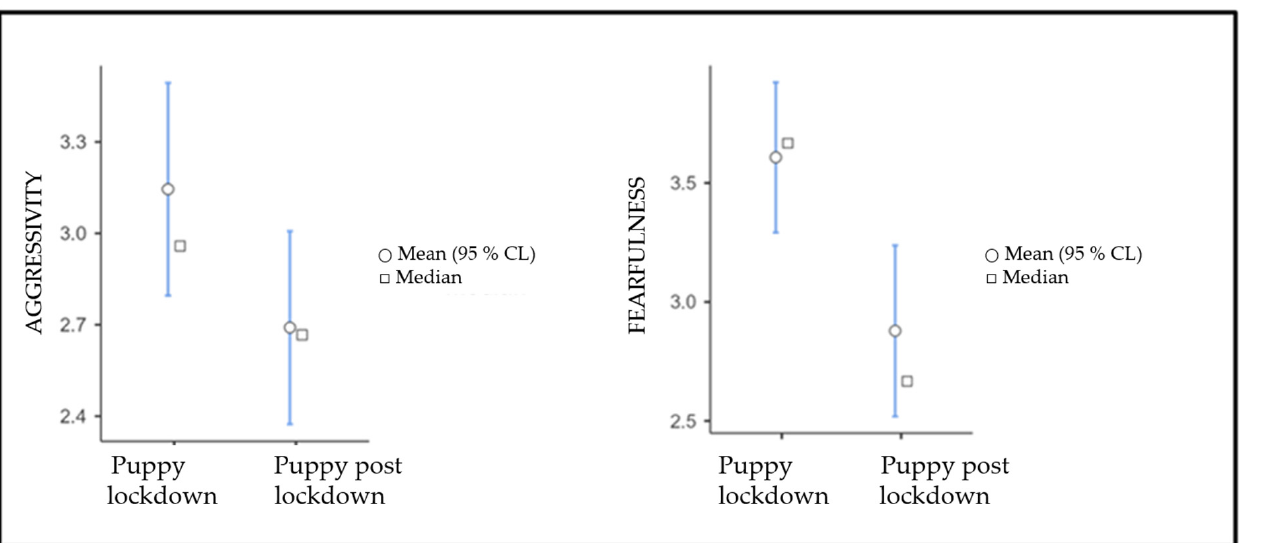
Table 4. Independent samples t -test on the facets that emerged from the construct validity analysis. Significance < p a 0.05; >0.10 indicates a statistical trend close to significance.